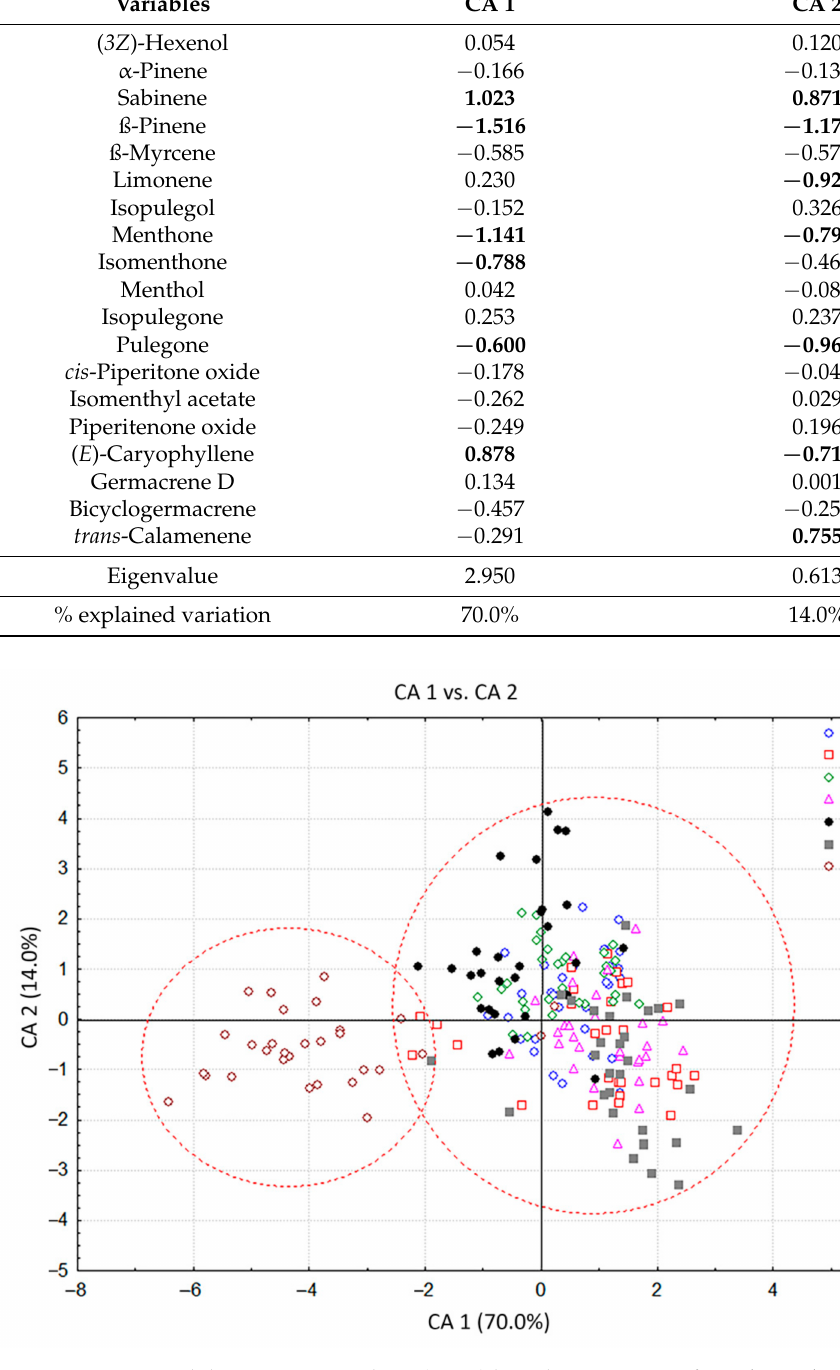
Figure 3. Canonical discriminant analysis (CDA) based on contents of 19 Clinopodium pulegium HS volatiles isolated from 210 plants of seven a priori